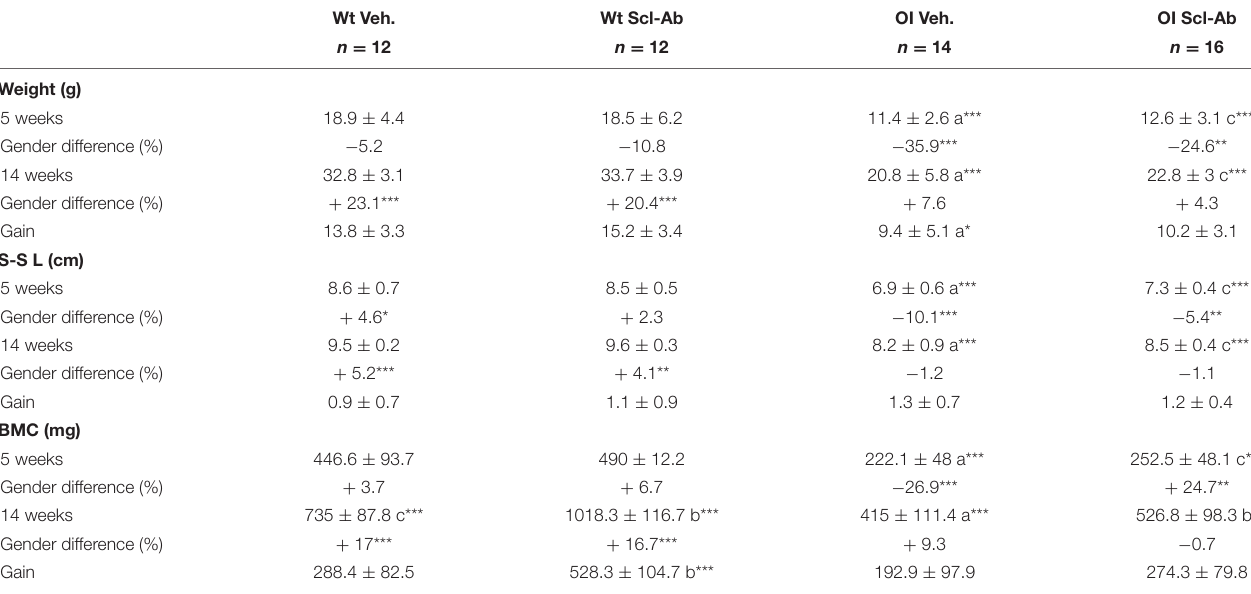
TABLE 1 | Weight, snout–sacrum length (S-S L), and whole-body bone mineral content (BMC) assessed with dual-energy X-ray absorptiometry in male wild-type (Wt) and oim/oim (OI) mice before and after 9-week treatment with either vehicle (Veh.) or Scl-Ab. Wt Veh. Wt Scl-Ab OI